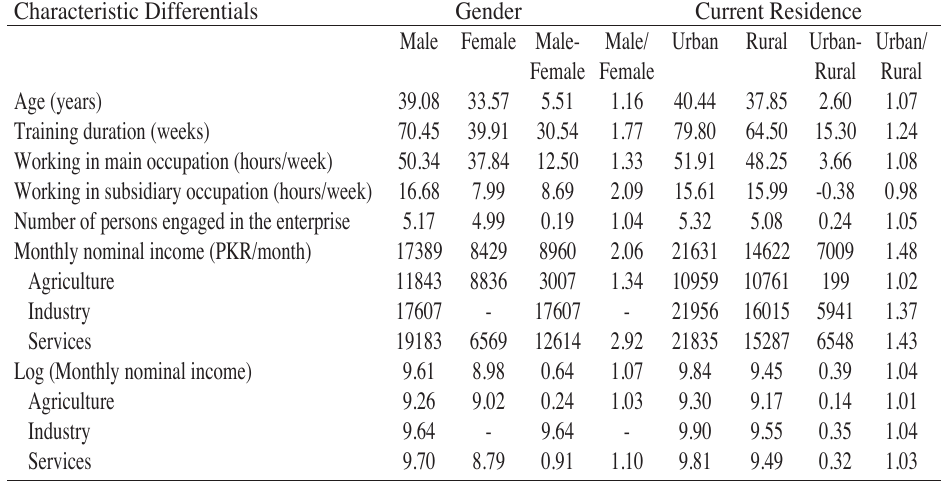
Table 1: Summary statistics of occupationally injured migrant workers’ differentials by gender and current